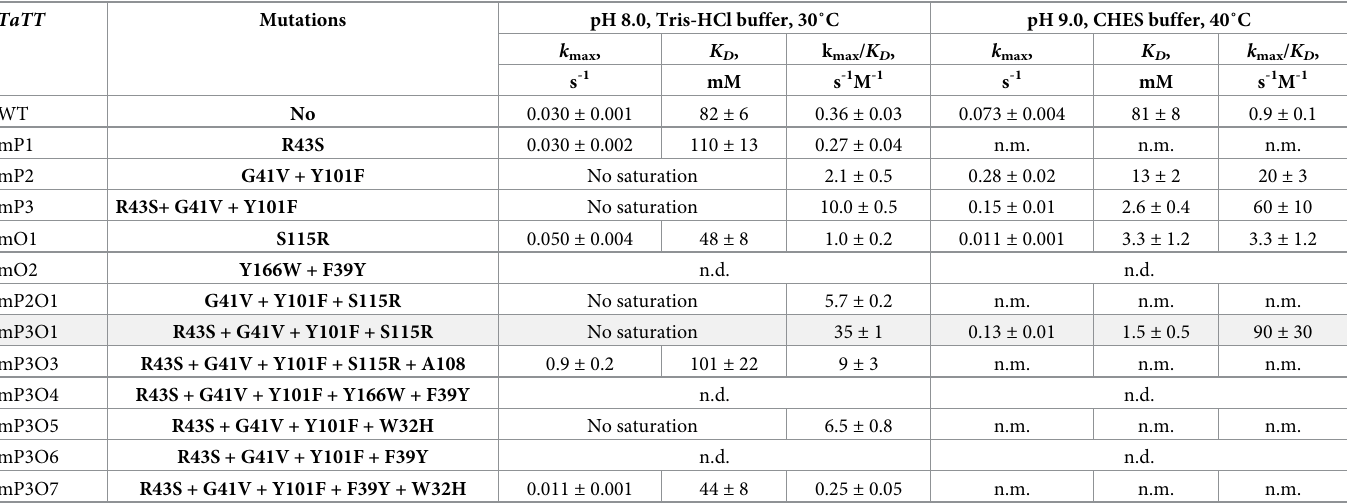
Variants containing changes in P-pocket are named mP1-mP3, variants containing changes in O-pocket are named mO1-mO4; variants with changes in both pockets are named mPxOx